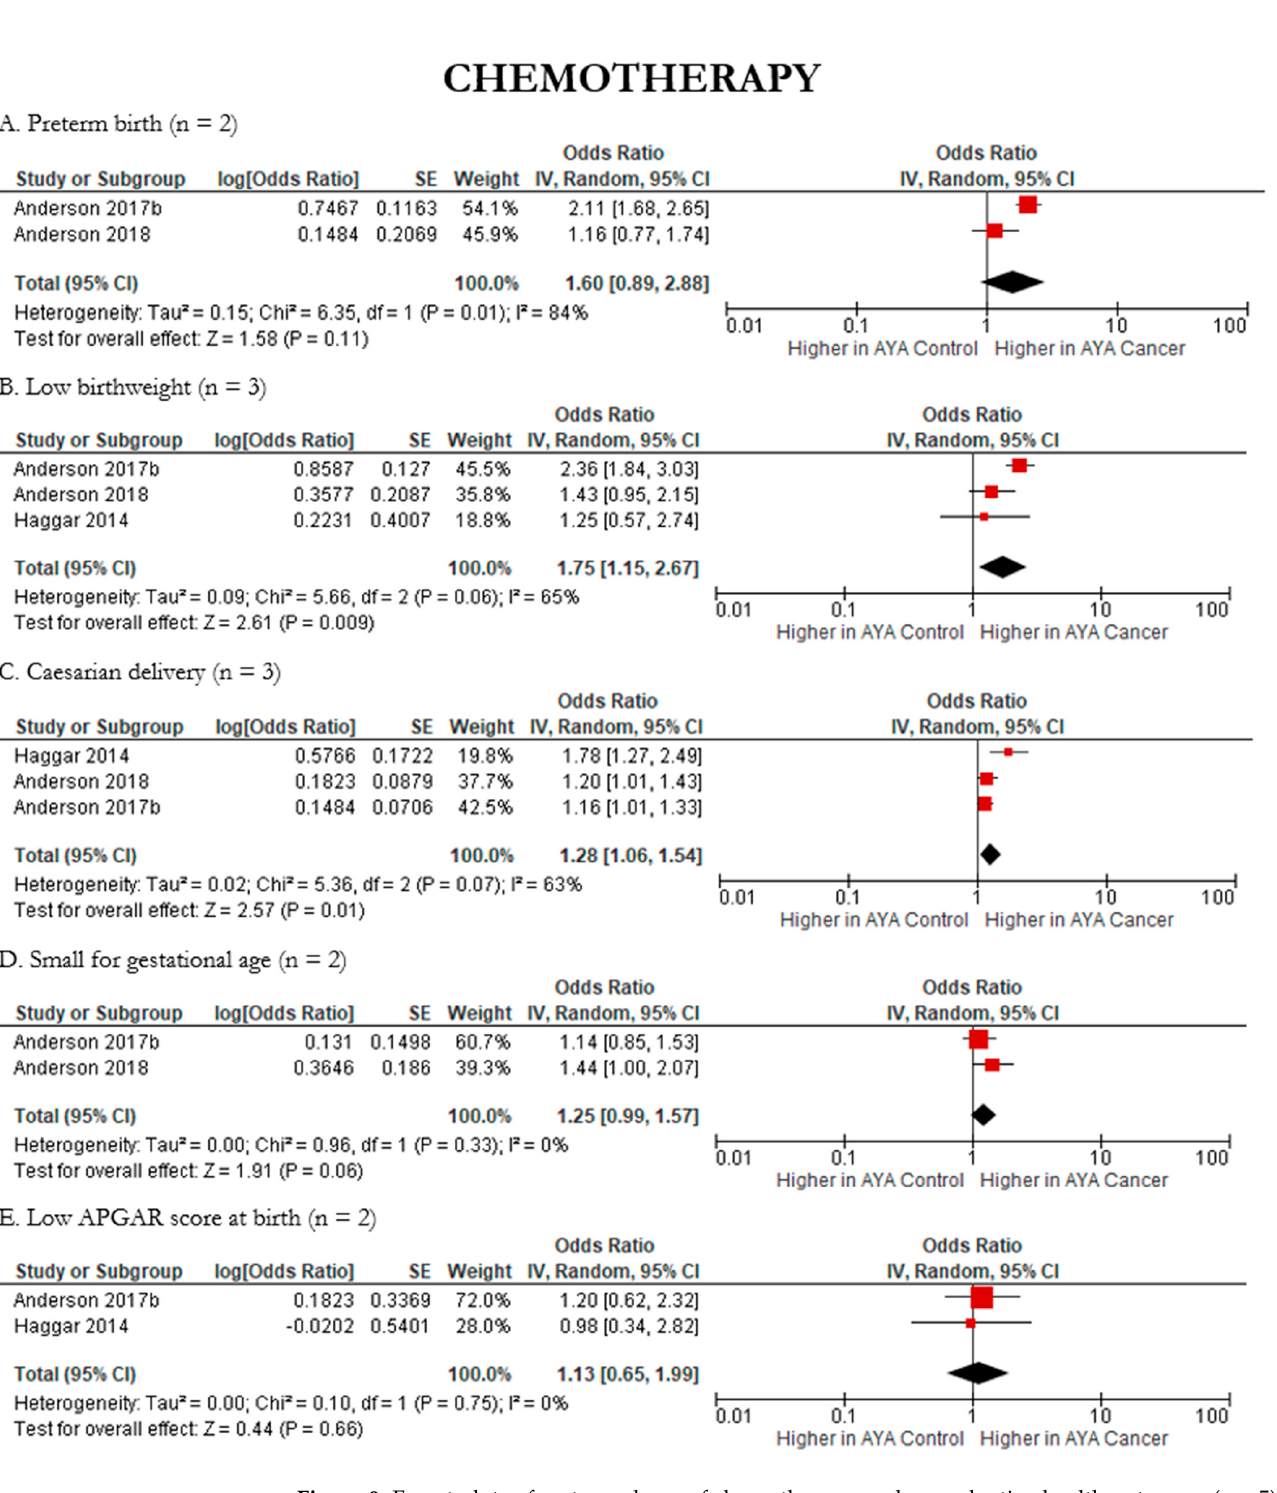
Figure 9. Forest plots of meta-analyses of chemotherapy and reproductive health outcomes (n = 5).